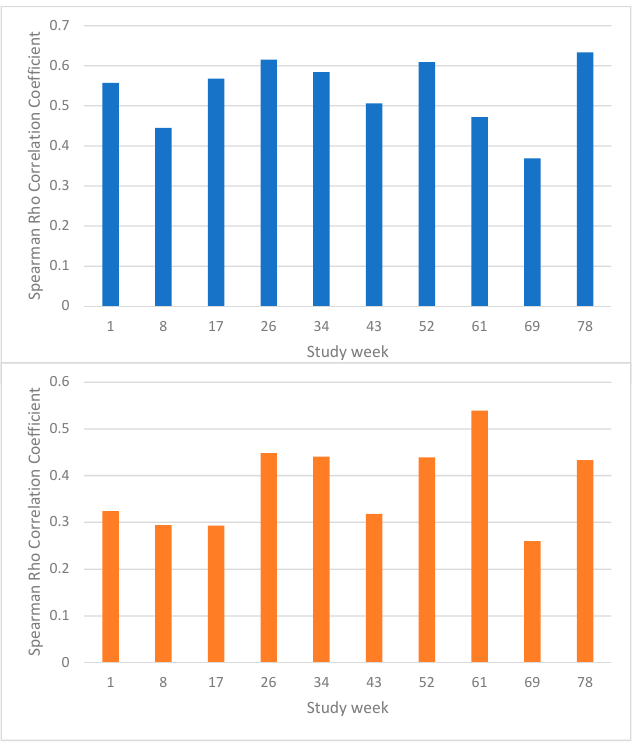
Figure 2. Correlations between Longitudinal Interval Follow-up Evaluation (LIFE) ratings and mood rating scales at different time-points—top panel LIFE depression vs Montgomery-Asberg Depression Rating Scale (MADRS), bottom panel LIFE mania vs Young Mania Rating Scale (YMRS).